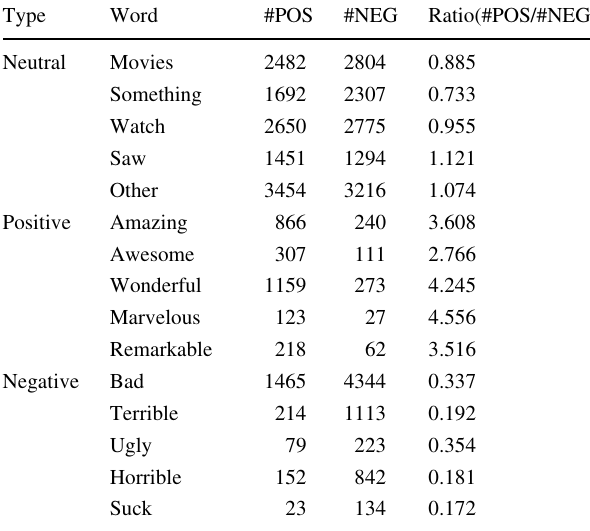
Table 2 Some commonly used words and their statistics